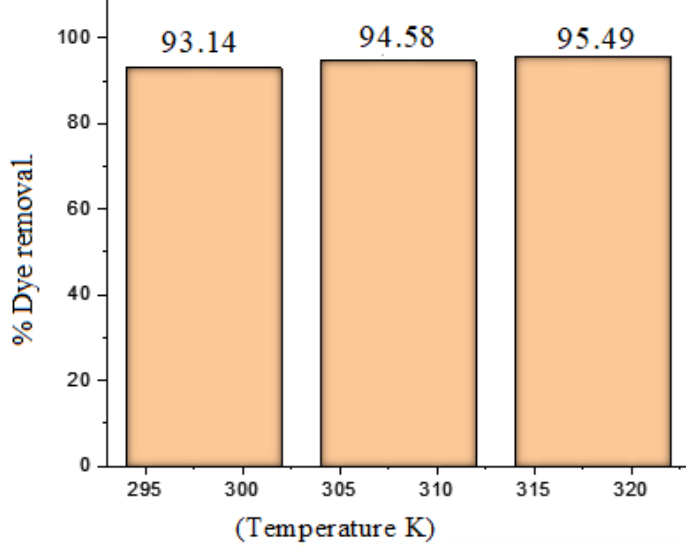
Figure 18. Influence of the temperature on the perecentage dye removal.